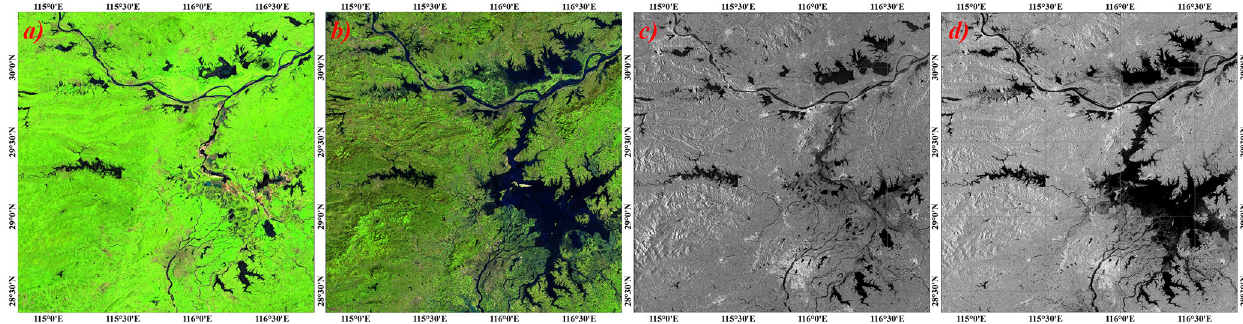
Figure 4. The lowest- and highest-water-level features derived from (a–b) Landsat optical reflectance time-series data and (c–d) the Sentinel- 1 SAR imagery using the time-series compositing method in Poyang Lake,